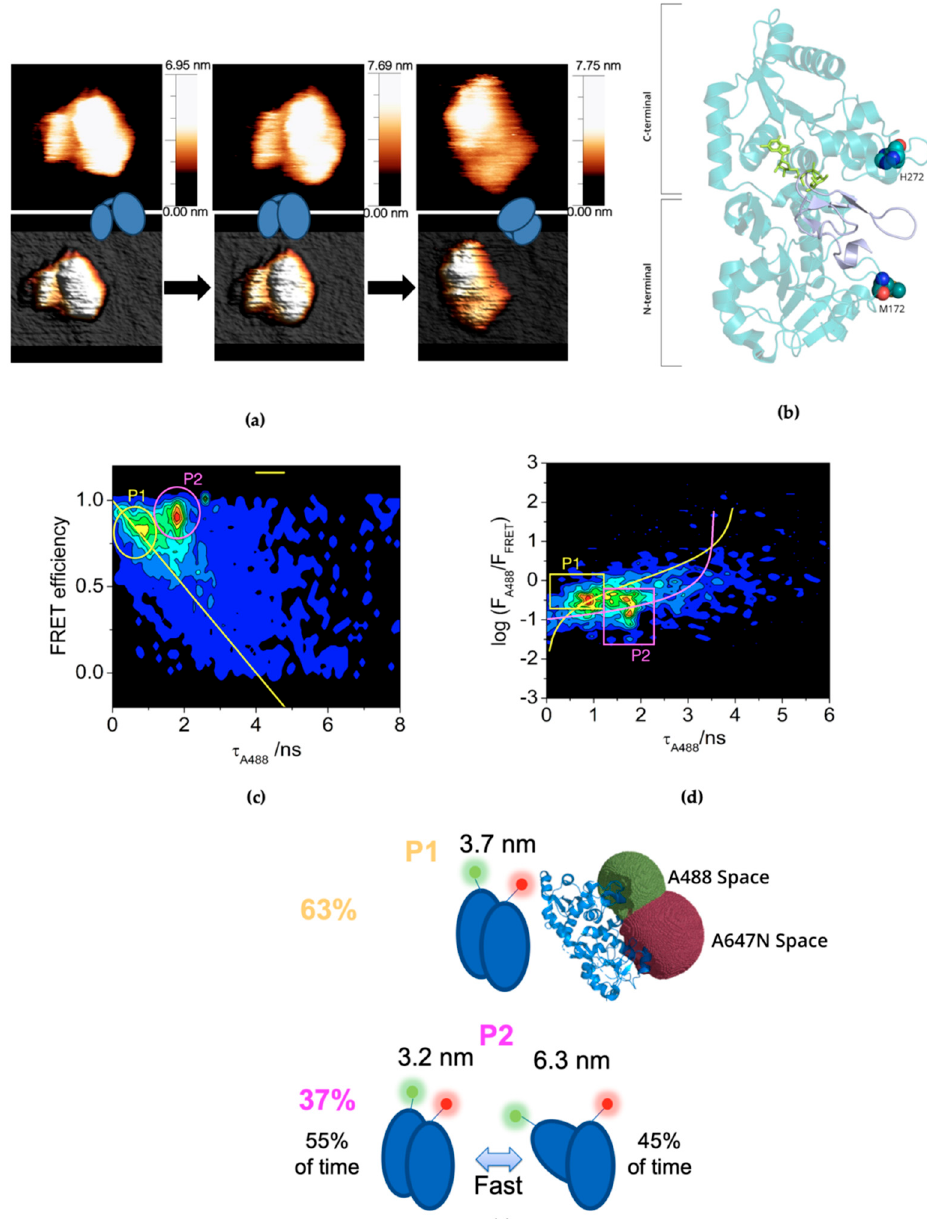
Figure 1. ( a ) Compact structures visualized in 2D and 3D for the same Ce PoFUT1 apo molecule in the presence of GDP in three consecutive collected AFM images. Images present a high-level contrast to show better the domains. The features appear next to outlined ball shapes that represent the species found. ( b ) Localization of residues M172 and H272 residues in Ce PoFUT1 structure. The figure depicts the structure of Ce PoFUT1 complexed with GDP-Fuc (PDB entry 3ZY4) and EGF1 (T101A). Note that the EGF1 shown in the structure comes from the crystal structure of mouse PoFUT1 ( Mm PoFUT1) complexed to EGF1 (T101A) and GDP-Fuc (PDB entry 5KY3). Ce PoFUT1 and EGF1 are shown as a cartoon representation in teal and violet colors, respectively. GDP-Fuc is shown as green carbon atoms. The mutated residues are depicted as spheres. ( c and d ) Multiparametric SMF-FRET correlograms of dual-labeled Ce PoFUT1 in solution. Both correlograms of FRET efficiency vs τ A488 ( c ) and log (F A488 /F FRET ) vs τ A488 ( d ) show the presence of two Ce PoFUT1 populations. P1 (static population) and P2 (dynamic population) are shown in yellow and magenta, respectively. In both cases, the yellow line represents the theoretical relations between FRET efficiency and τ A488 for a static population. Magenta line in ( d ) represents a dynamic population interconverting between a low-FRET and a high-FRET state, according to eq. (2). ( e ) Percentages of P1 and P2 and estimated donor-acceptor distances for both populations.